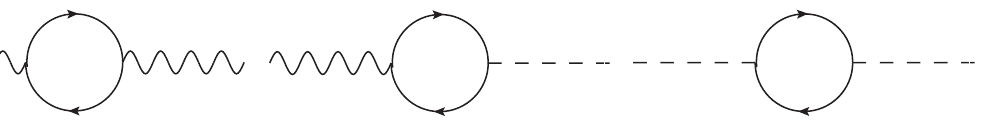
Figure 1 . Self-energy diagrams in ZZ , ZG , GG propagators.